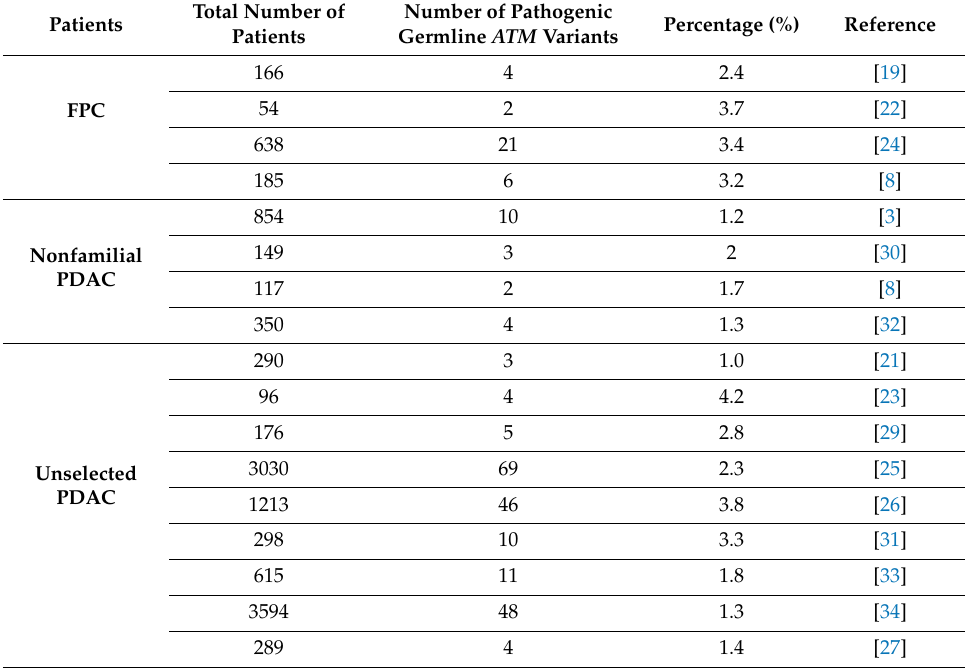
Table 1. Pathogenic germline ATM variants in patients with pancreatic ductal adenocarcinoma (PDAC). Total Number of Patients